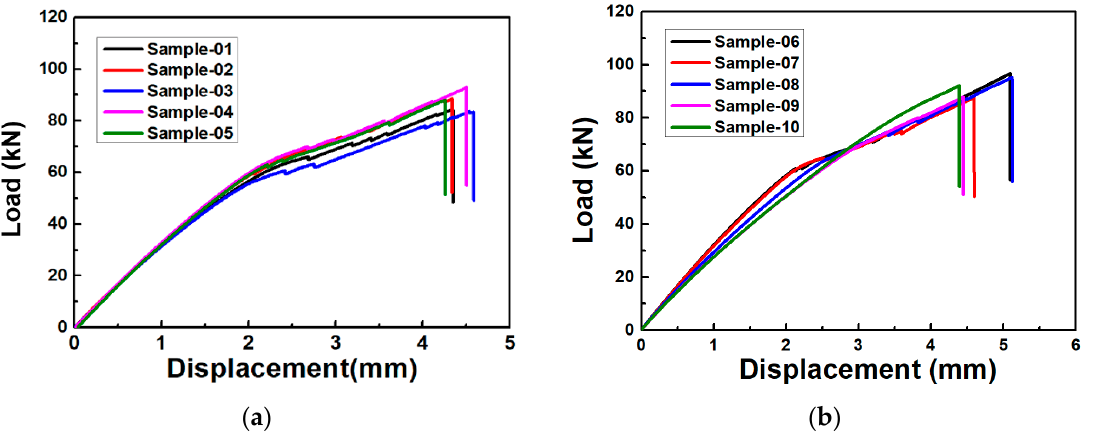
Figure 11. Load-displacement curves of the typical tensile behaviors ( a ) and the residual properties ( b ) obtained from Step 1 and Step 4, respectively.